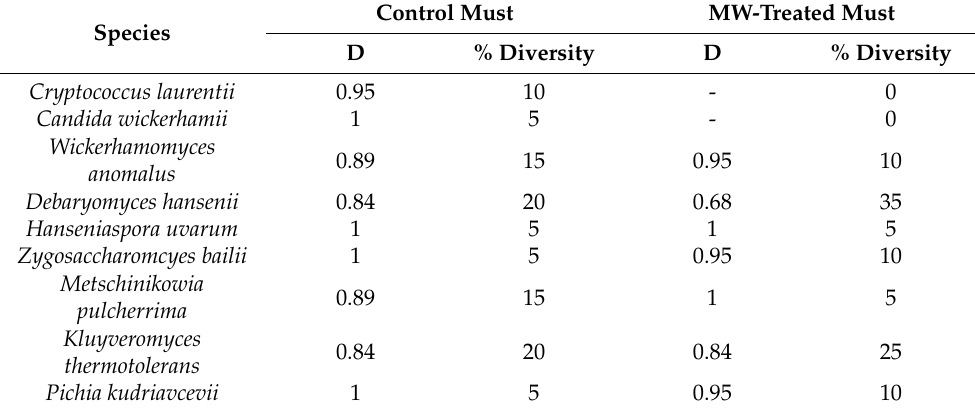
Table 1. Diversity study of the must yeasts: D (Simpson index) and % diversity of each species. Control Must MW-Treated Must Species D % Diversity D % Diversity 0.95